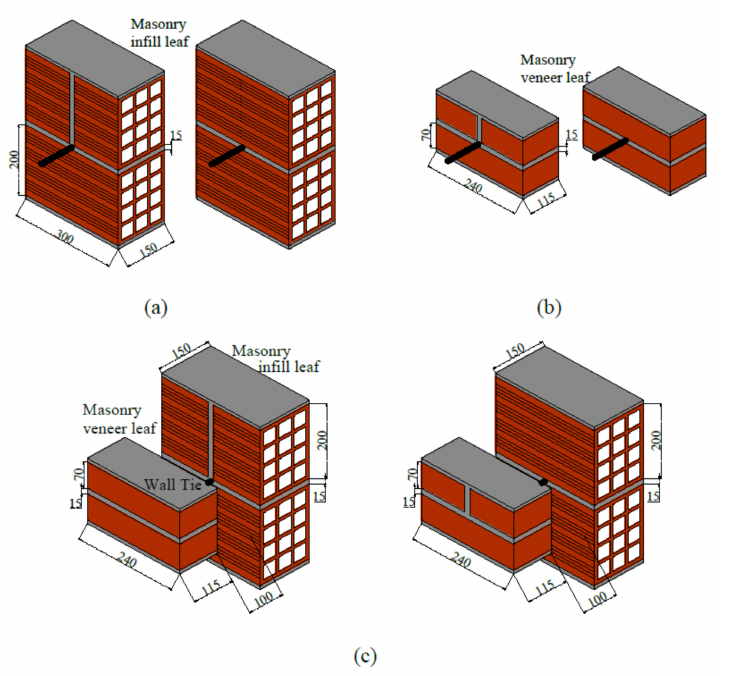
Figure 4. Test specimens: ( a ) brick masonry infill with embedded tie; ( b ) brick masonry veneer with embedded tie; ( c ) complete assemblage of brick masonry prims connected [34]. Units in mm.